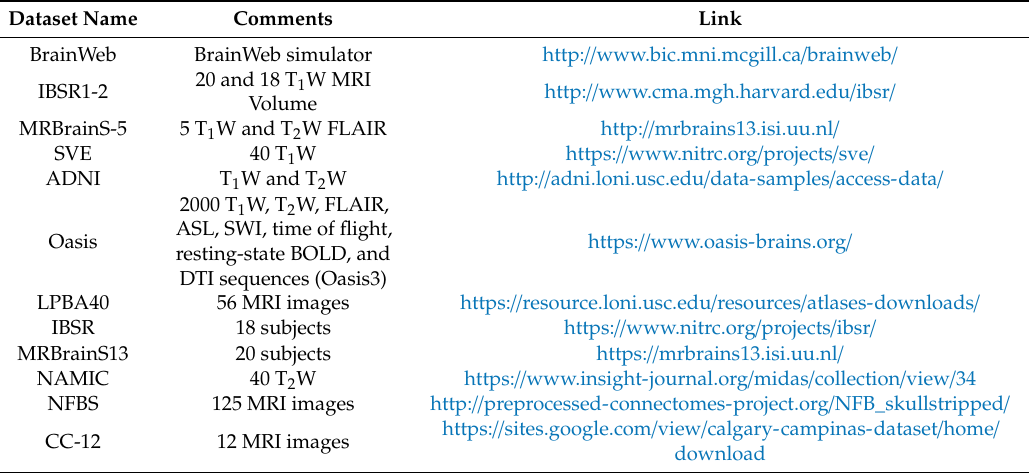
Table 1. Summary of publicly available datasets.